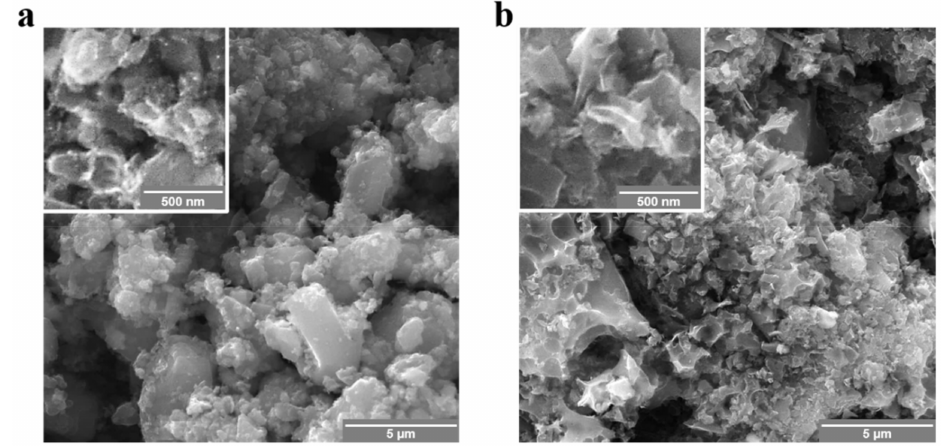
Figure 1. SEM images at different magnifications of ( a ) the physically CO 2 -activated carbon and ( b ) the chemically NaOH-activated